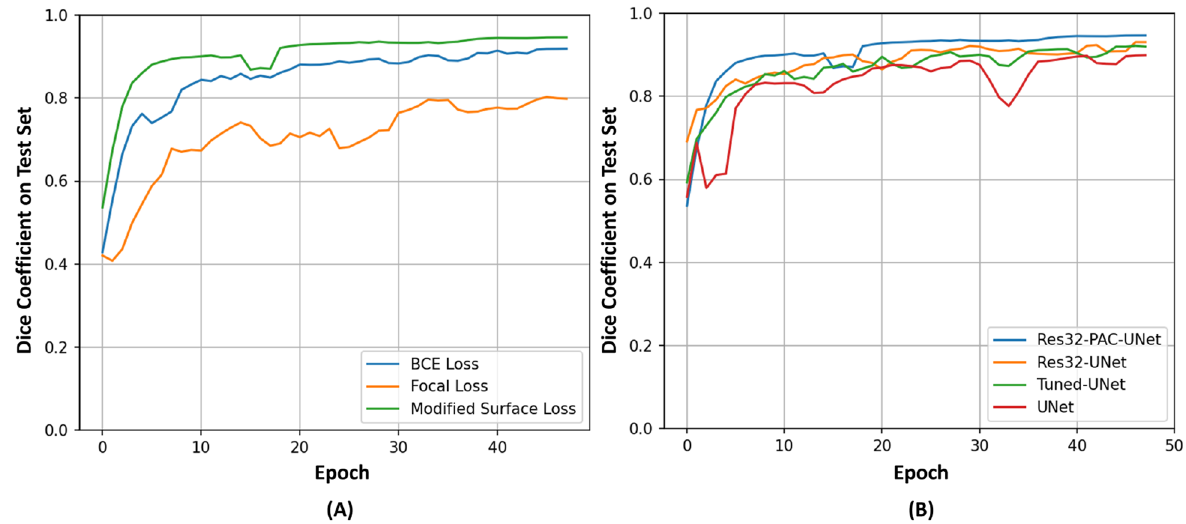
Figure 4. Evolution of DC during the first 50 epochs of training on the test set: ( A ) Res32-PAC-UNet trained with three different loss functions. ( B ) Proposed models trained with modified surface loss